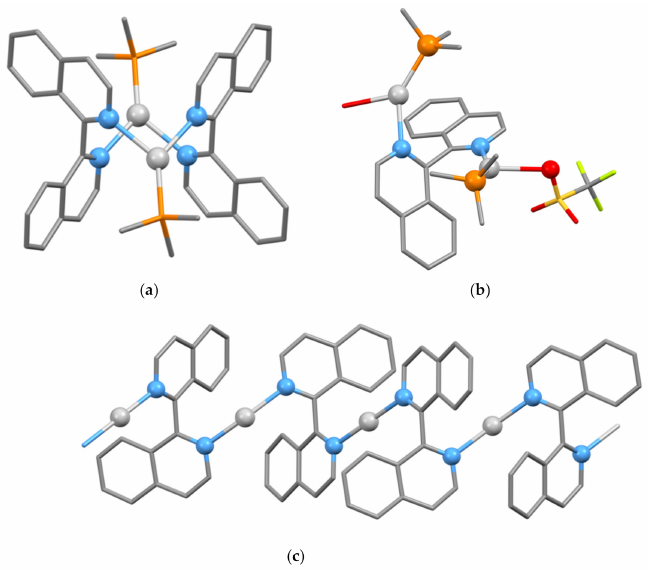
Figure 17. ( a ) The [(Ph 3 P)Ag( µ -biiq) 2 Ag(PPh 3 )] 2+ cation present in [(Ph 3 P)Ag( µ -biiq) 2 Ag(PPh 3 )]- (ClO 4 ) 2 · 3Me 2 CO with donor atoms and silver atoms shown as balls, only the ipso carbon atoms of the Ph 3 P ligands are shown, and hydrogen atoms are omitted for clarity; ( b ) the compound [(CF 3 SO 3 )(Ph 3 P)Ag( µ -biiq) 2 Ag(OH 2 )(PPh 3 )] + cation present in [(CF 3 SO 3 )(Ph 3 P)Ag( µ - biiq) 2 Ag(OH 2 )(PPh 3 )](CF 3 SO 3 ) · CHCl 3 with donor atoms and silver atoms shown as balls, only the ipso carbon atoms of the Ph 3 P ligands shown and hydrogen atoms omitted for clarity; ( c ) the one-dimensional [{Ag( µ -biiq)} n ] n + cation in [{Ag( µ -biiq)} n ](CF 3 SO 3 ) n · n H 2 O with donor atoms and silver atoms shown as balls and hydrogen atoms omitted for